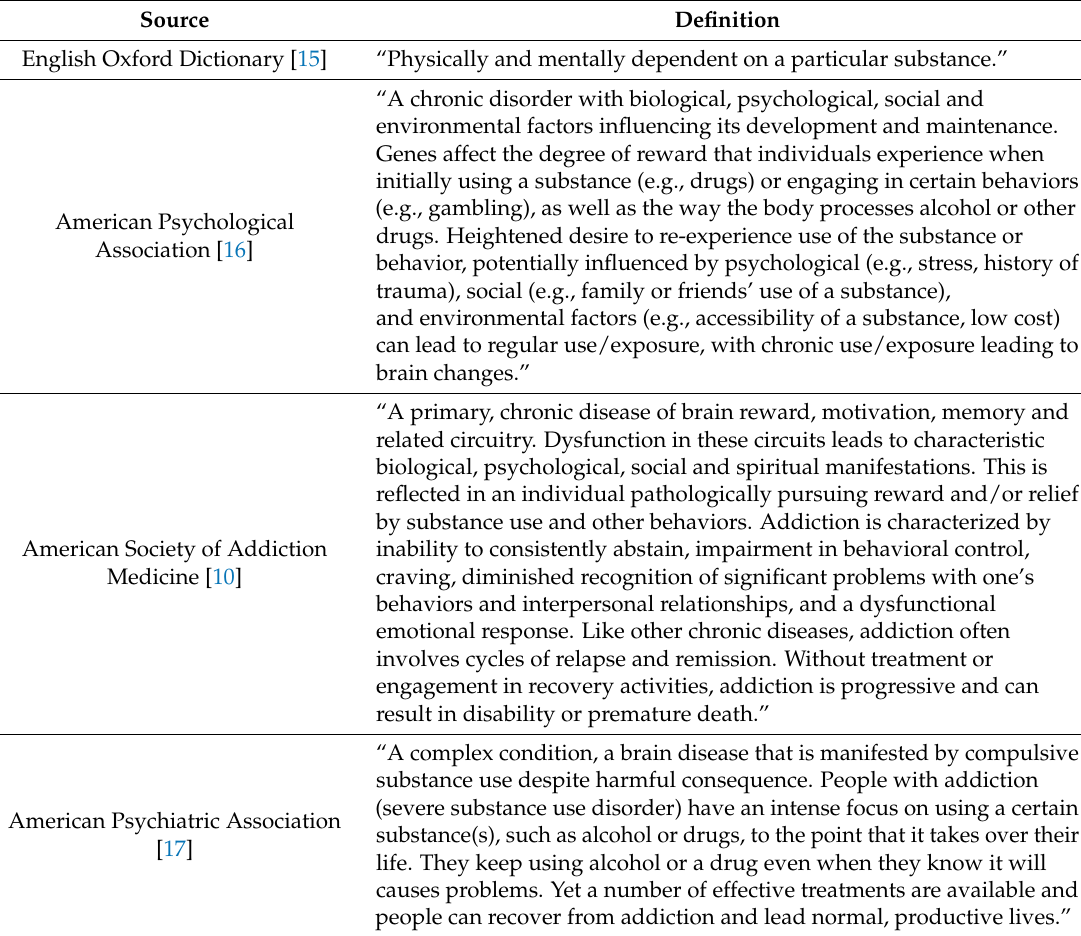
Table 1. Definitions of